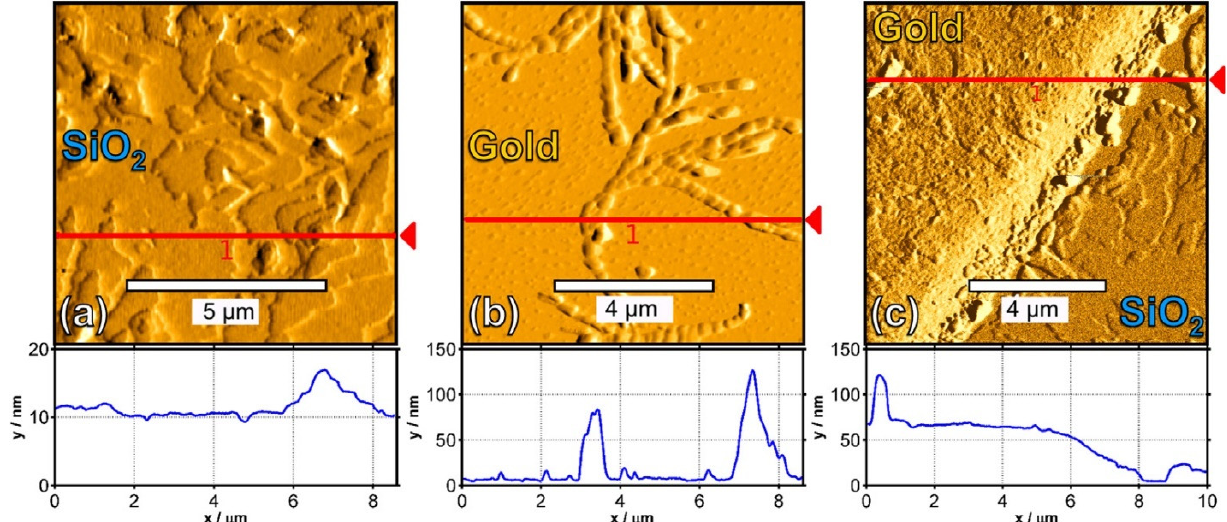
Figure 14. Pentacene deposition at 350 K: 7.5 monolayers on SiO 2 ( a ) and gold ( b ), and on the gold contact–channel transition region ( c ). The corresponding cross-sections are indicated in the AFM scans by a line and shown underneath correspondingly. Reprinted with permission from ref. [92]. 2015 Elsevier.